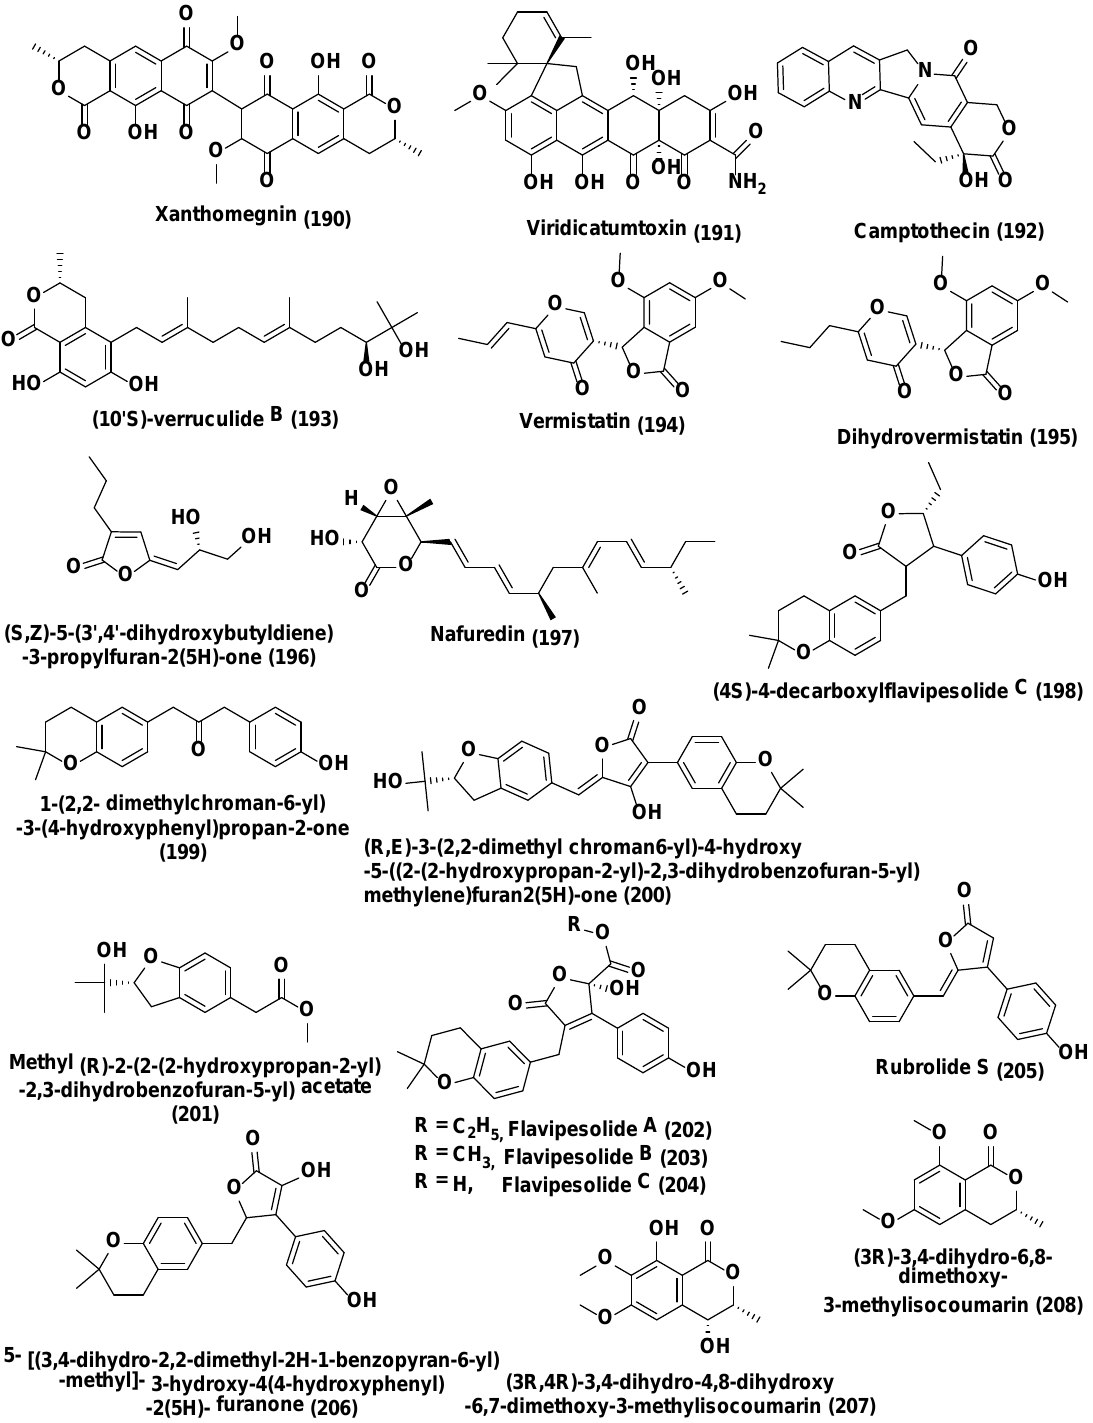
Figure 10. Structures of metabolites obtained from Epigenetic modification in endophytic fungi ( 190 – 208 ). Vasanthakumari et al. [121] reported the attenuation of camptothecin ( 192 ) (Figure 10) yield in endophytic fungi obtained from camptothecin fabricating plants, Nothapodytes nimmoniana and